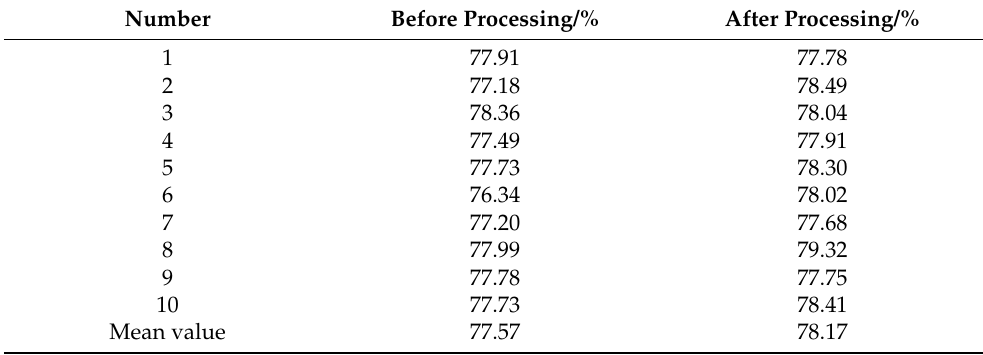
Table 3. Classification accuracies achieved by DT classifier on the data set before and after standard- ization